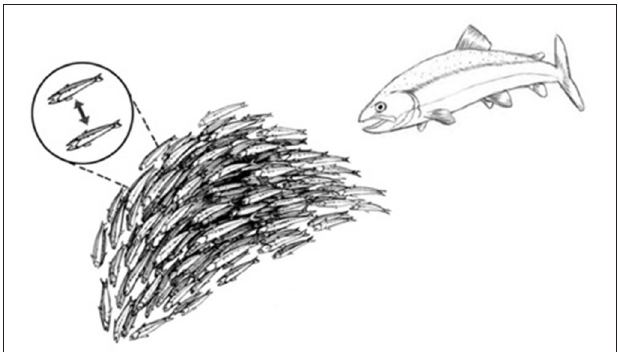
FIGURE 3 | Schools of fish manifest self-organized behavior. A school of fish, as an organized group, effectively flees from a predator fish. The dashed-line inset shows that the shape and direction of the school of fish is actually self-organized by a relatively small number of visual signals exchanged between adjacent fish.